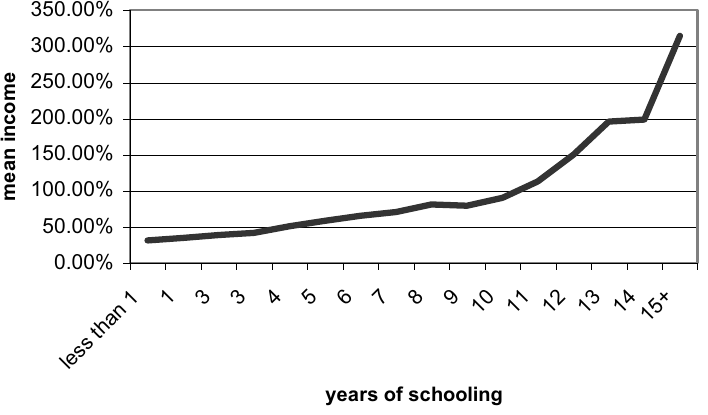
Fig. 5 – Mean income, by years of schooling (reais, October 2002). Source: IBGE 2003.